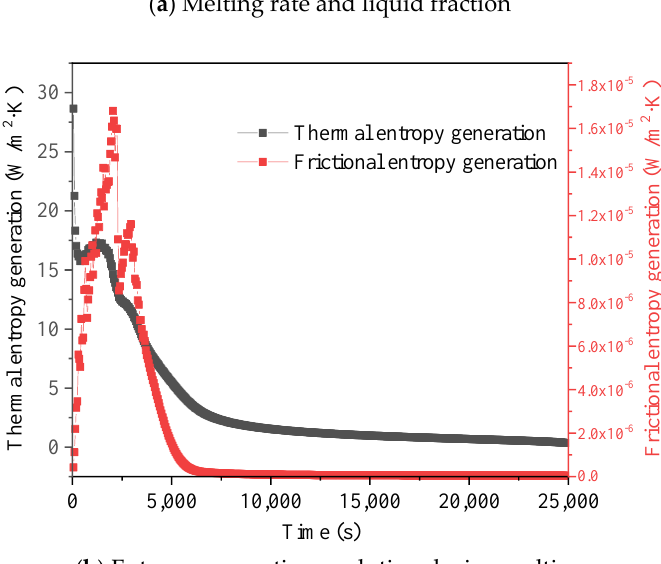
Figure 5. Liquid fraction and entropy generation for melting process.